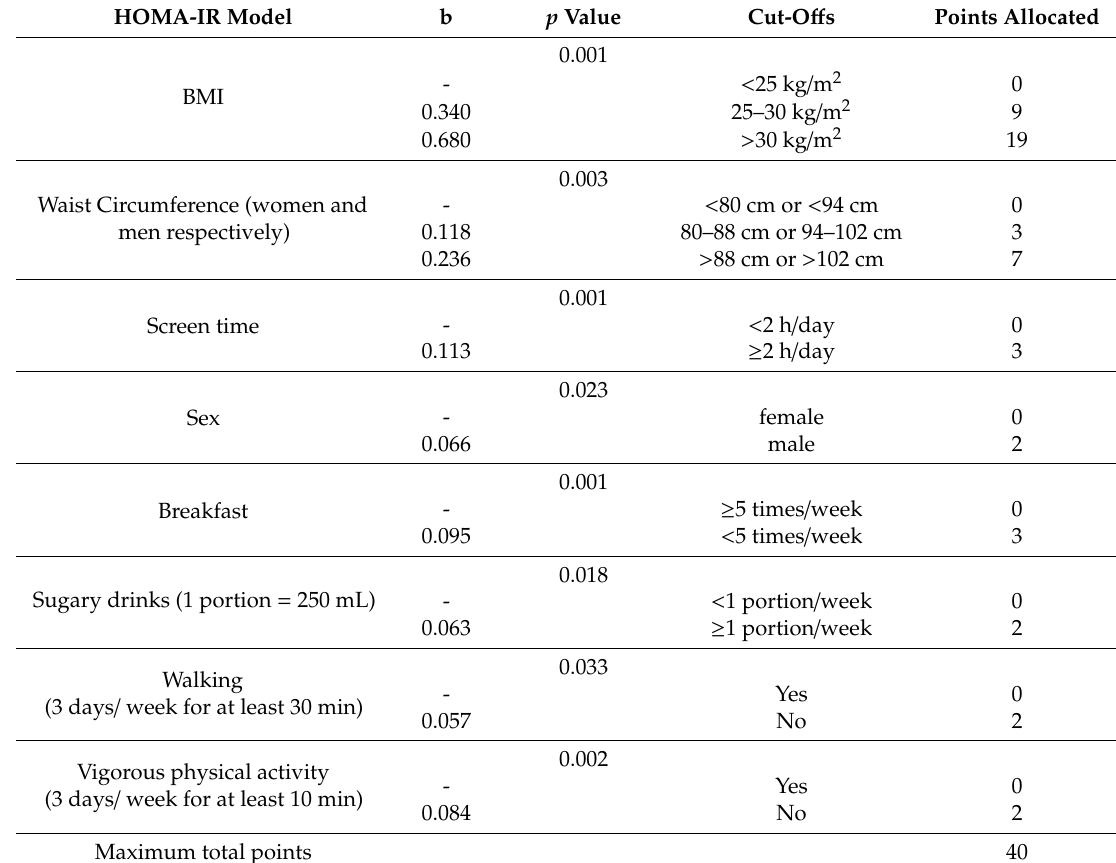
Table 2. Scores for European IR Risk